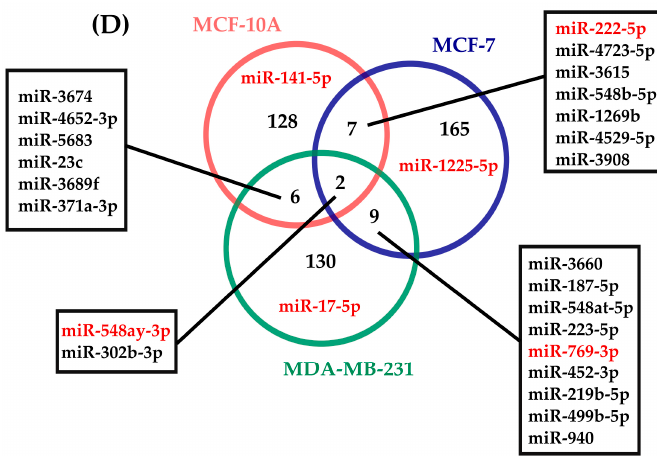
Figure 2. Rhythmic expression of miRNAs identified in three breast cell lines. The heat maps depict the expression level of miRNAs over 28 h (hours 12–40 of the 48 h study) in ( A ) MCF-10A; ( B ) MCF-7; and ( C ) MDA-MB-231 cells. In addition, the heat maps show 6 different clusters of miRNAs that depict marked phases. Brown colors represent higher expression values, while yellow colors represent lower expression values. Expression values are z-scaled relative to each cell line; ( D ) Venn diagram of 143, 183, and 147 miRNAs that were rhythmically expressed over 28 h in MCF-10A, MCF-7, and MDA-MB-231. The diagram also shows miRNAs that exhibited rhythmicity across cell lines and were selected for RT-qPCR validation (red).